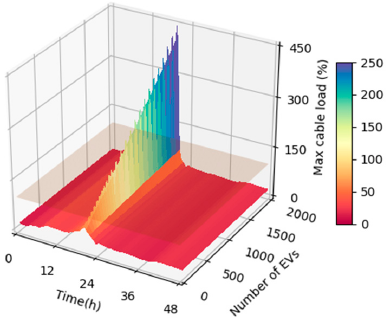
Figure 8. The maximum cable load in Scenario 1 in the upper feeder for different numbers of EVs.